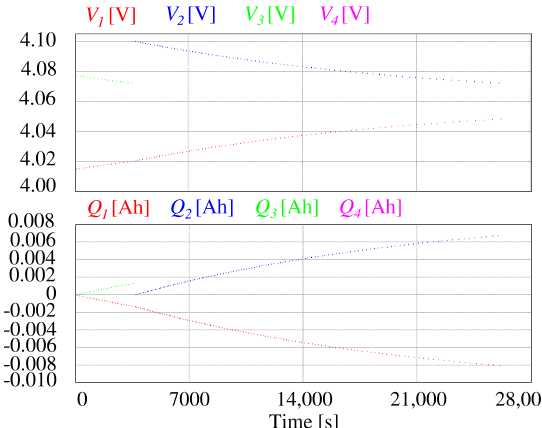
Figure 14. Equalization of a four-cell battery bank using the switched capacitor scheme.